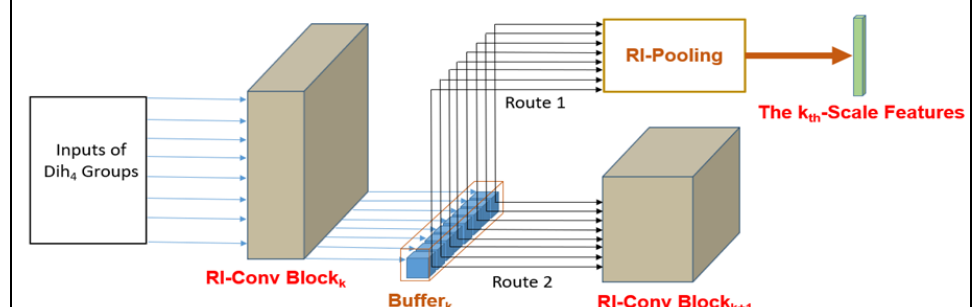
Figure 6. Proposed RIMS-CNN model.